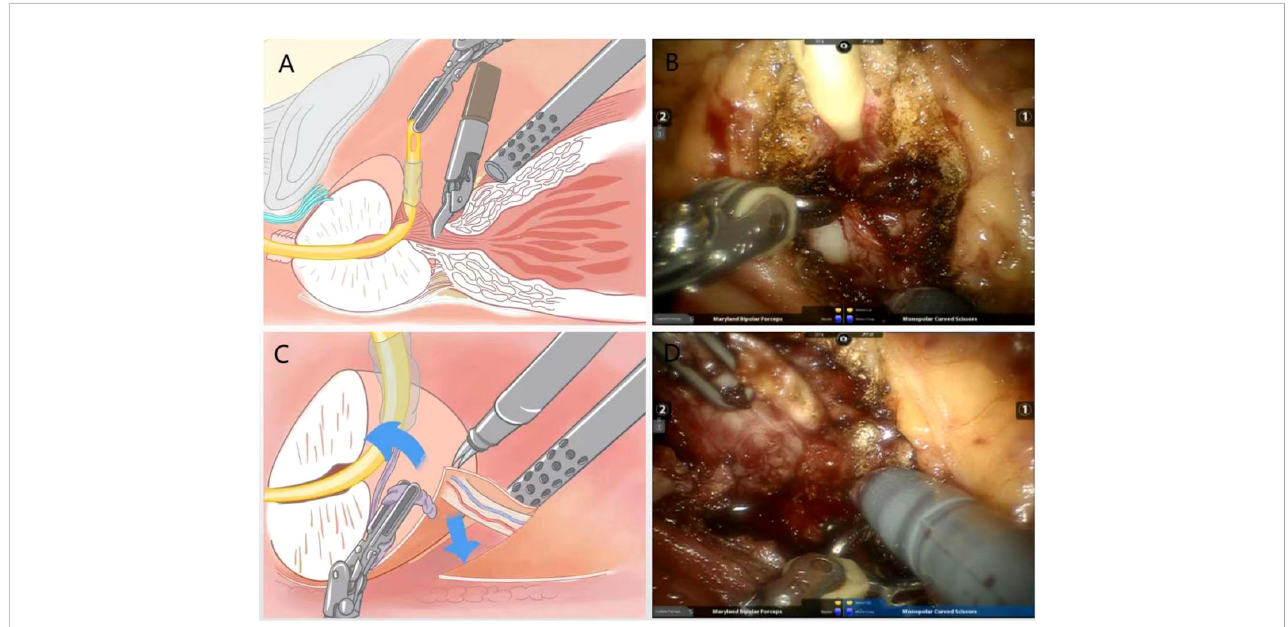
FIGURE 1 (A) Schematic diagram of bladder neck preserving surgery; (B) Practical diagram; (C) Schematic diagram of the surgical treatment of the right vascular tip of the prostate using the no-clips technique; (D) Practical